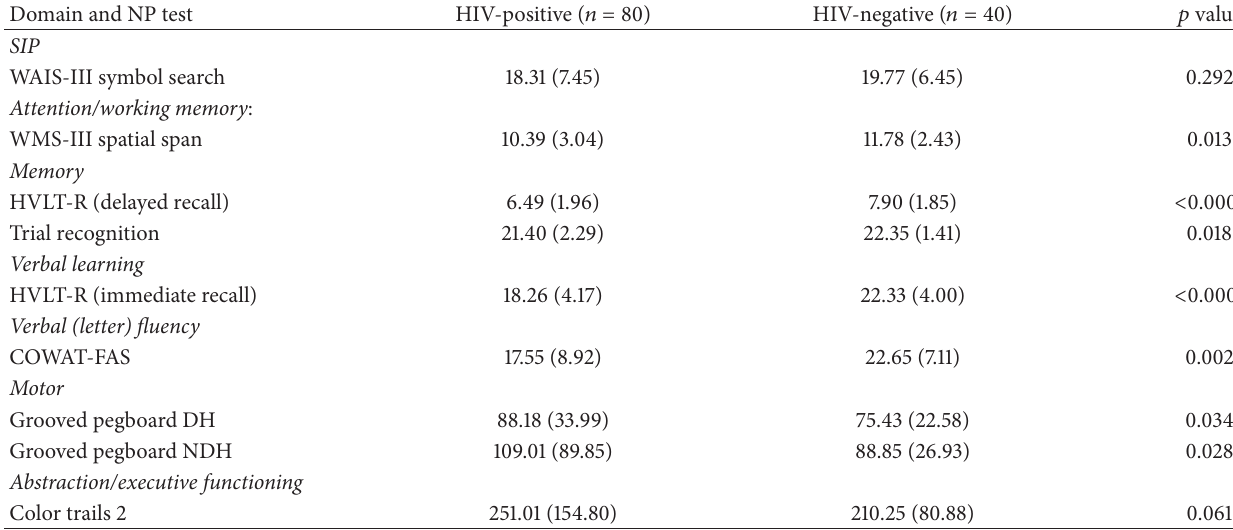
Table 2: Neuropsychological tests score of HIV-positive and HIV-negative